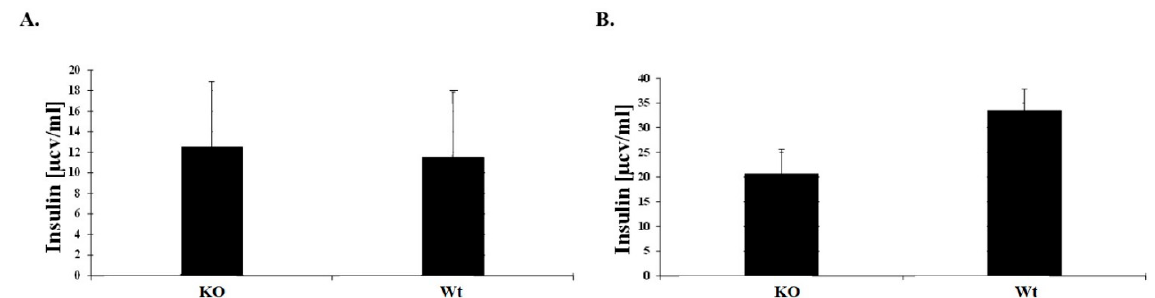
Figure 4. CD24 deficiency and glucose uptake in 9–12 weeks old mice. After fasting, mice were intraperitoneally injected with glucose (1 g/kg body weight). ( A ) Baseline insulin levels were measured from mice serum by ELISA assay. ( B ) Insulin levels were measured 20 min after glucose injection.